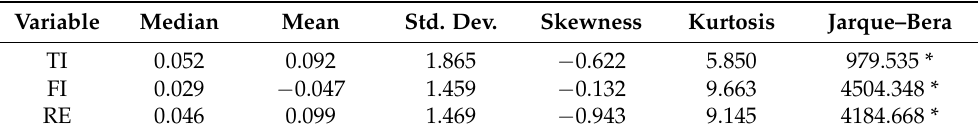
Figure 2. The fluctuation-sequence charts of the TI, FI, and RE. ( a ) TI. ( b ) FI. ( c ) RE. The descriptive statistics of the indices for the fundamental characteristics are listed in Table 1. Table 1. Descriptive statistical results.